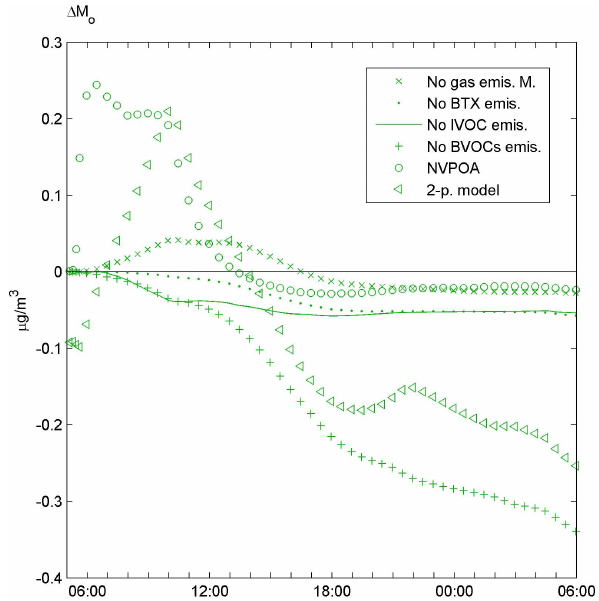
Fig. 11. Modeled organic PM2.5 mass difference ( 1 M o ) between the base case and the following case studies: (1) without any an- thropogenic gas phase emissions in Malm¨o, (2) no BTX emissions in and downwind of Malm¨o, (3) no IVOC emissions in and down- wind of Malm¨o, (4) no BVOC emissions downwind of Malm¨o, (5) with NVPOA in and downwind of Malm¨o and (6) the two-product model simulation.